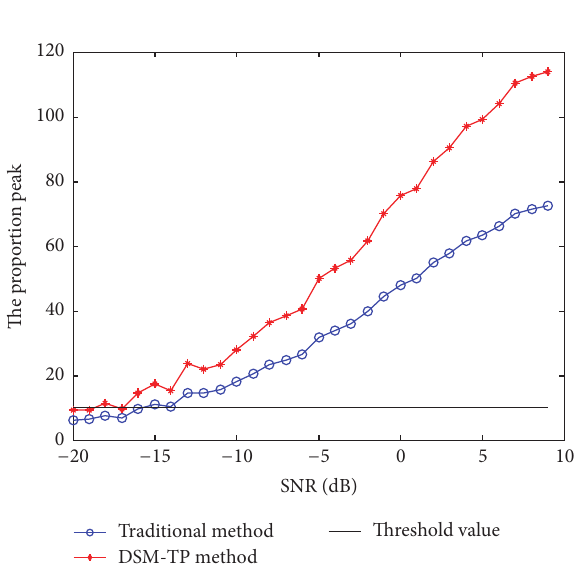
Figure 7: The calculated process of 𝑃 𝑖 .